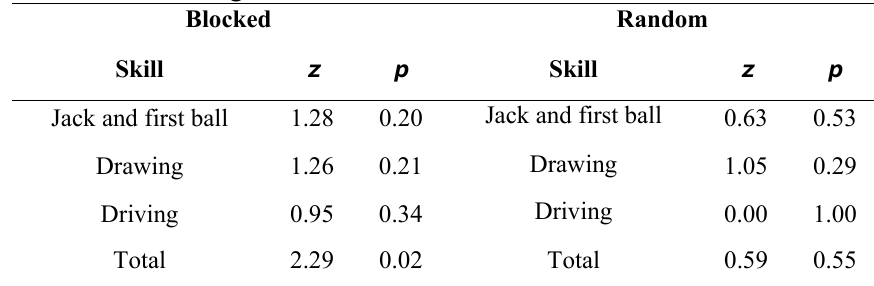
Results of Paired-Samples Wilcoxon Signed Rank Test for Differences between Respective Blocked and Random Training Schedules Pre- and Post- Tests Scores